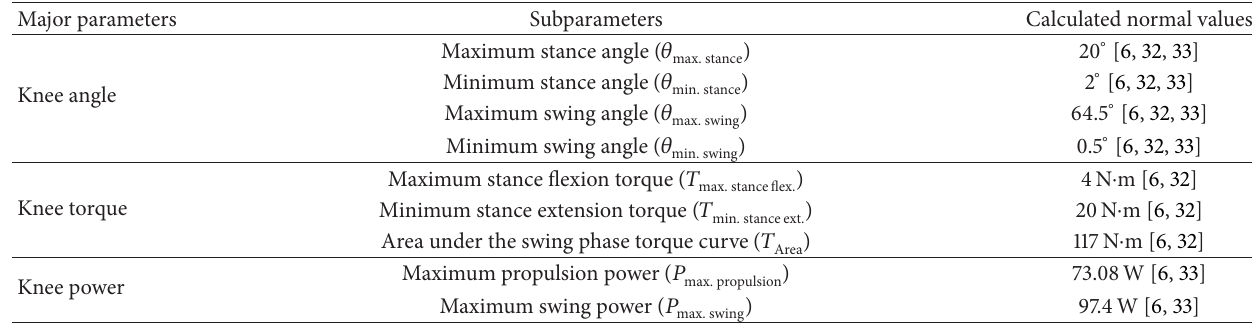
Figure 1: Flowchart of systematic survey of the literature based on PRISMA guideline. Table 1: Gait biomechanics parameters identified as performance